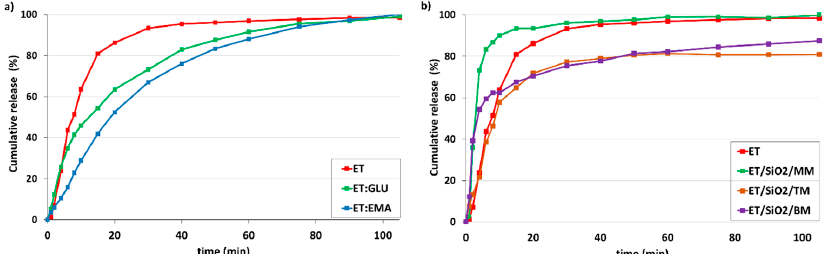
Figure 11. In vitro dissolution pro fi les of ( a ) ET and ET from ET:GLU, ET:EMA cocrystals, ( b ) ET and ET loaded in/on silica SiO 2 . Samples of ET in/on silica SiO 2 were prepared by three methods as described in legend. Water with pH 5.7 was used as a dissolution medium. The estimated error in measurements was found to be +/ − 1%.